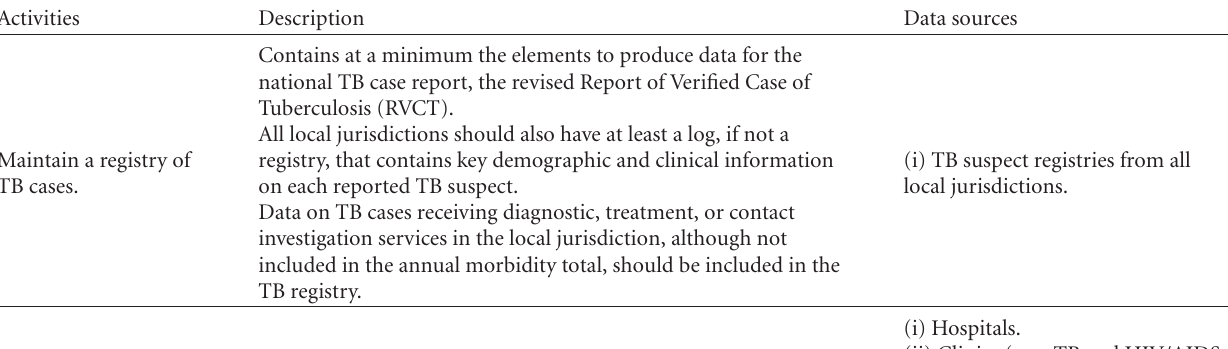
Table 1: Guidance ∗ for developing a written protocol for quality assurance for tuberculosis surveillance data, United States, 2011. (a) Case detection: Case detection is the discovery of the existence of a single instance of a specific disease or exposure, for example, tuberculosis (TB). This is a front-line surveillance activity and typically accomplished as a by-product of routine medical or veterinary care, laboratory work, or via an astute